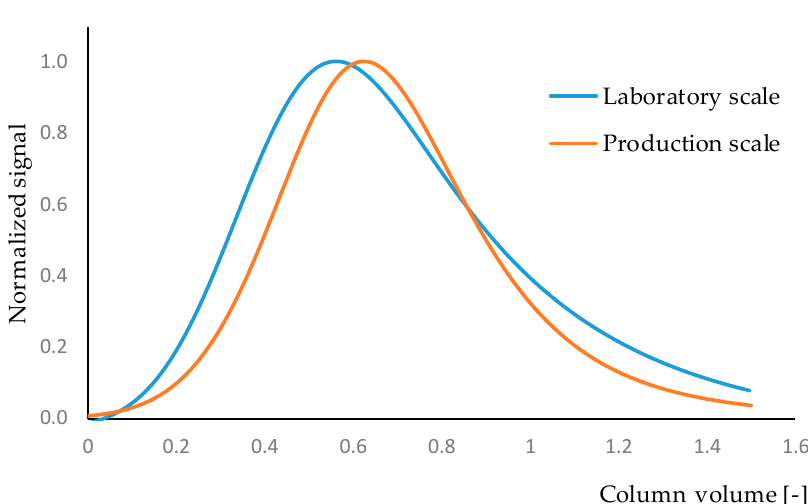
Figure 13. Direct comparison between the residence time distribution between production and laboratory scale.